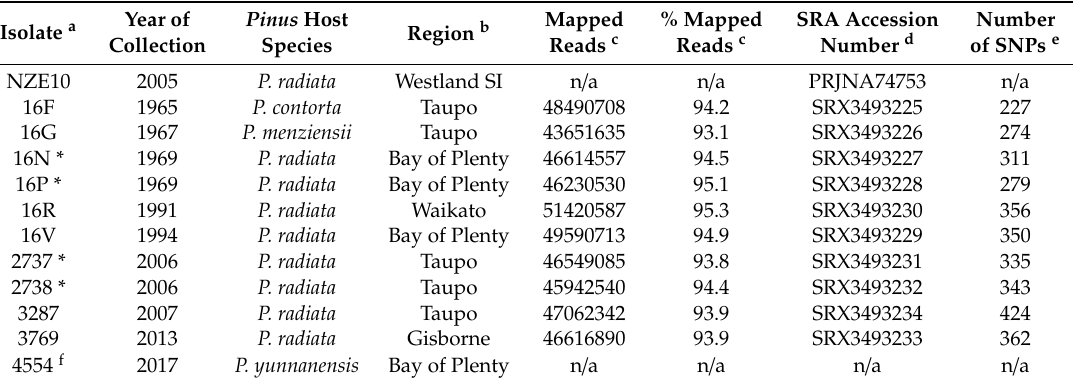
Table 1. Dothistroma septosporum isolates and genome mapping statistics.